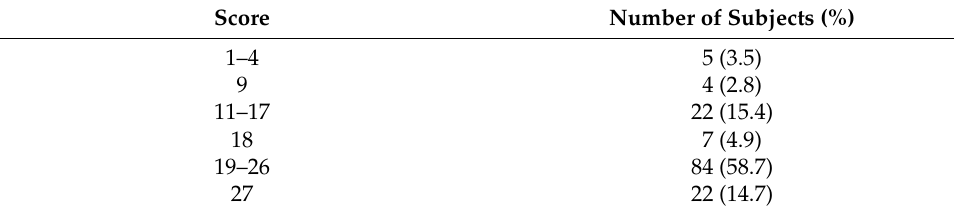
Table 4. IADL scores.